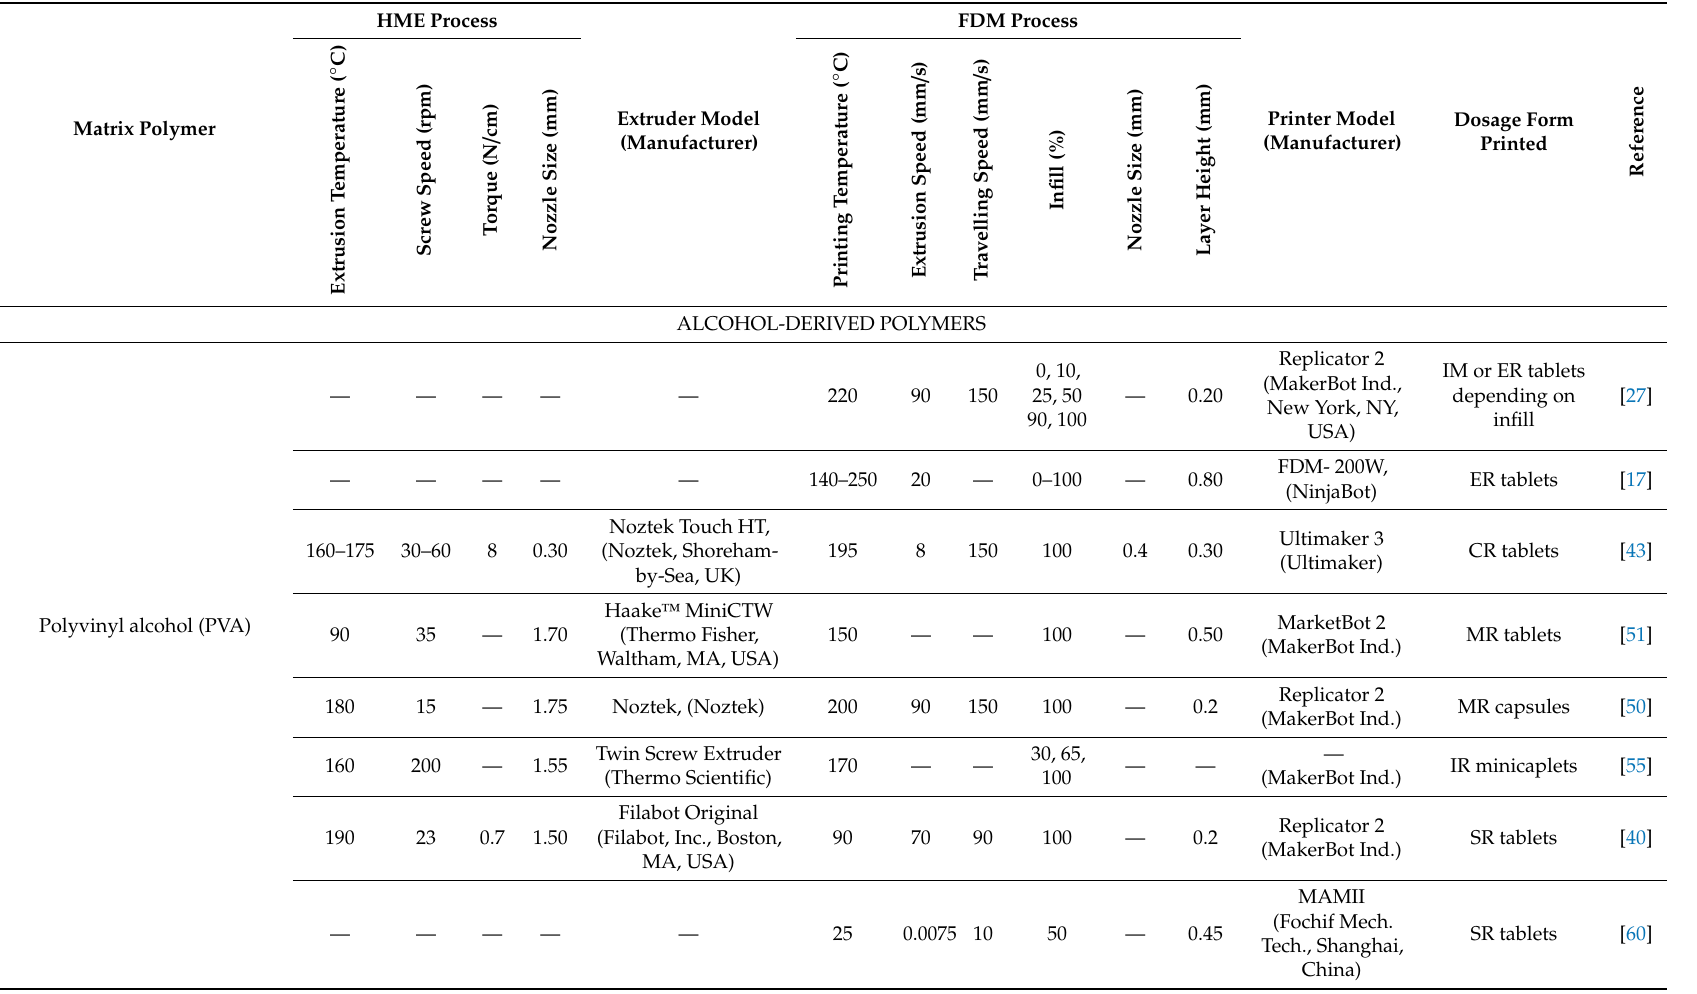
Table 4. Processing conditions and equipment used in HME of filaments and FDM 3D printing of dosage forms. The polymer used and the type of drug release obtained are